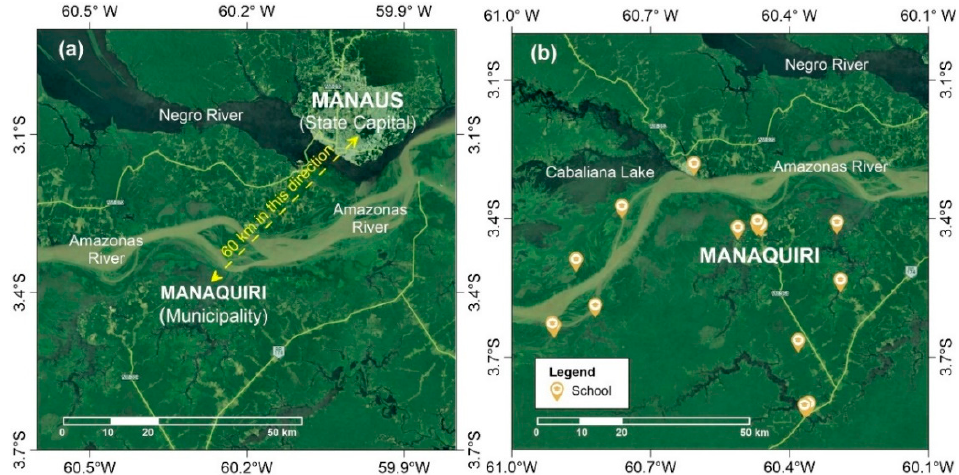
Figure 4. An example of a municipality in Amazonas State where river transport is necessary for education. ( a ) Location of Manaquiri municipality with respect to Manaus, the capital of Amazonas State. ( b ) Location of the main schools around Manaquiri. Adapted from Google Maps.